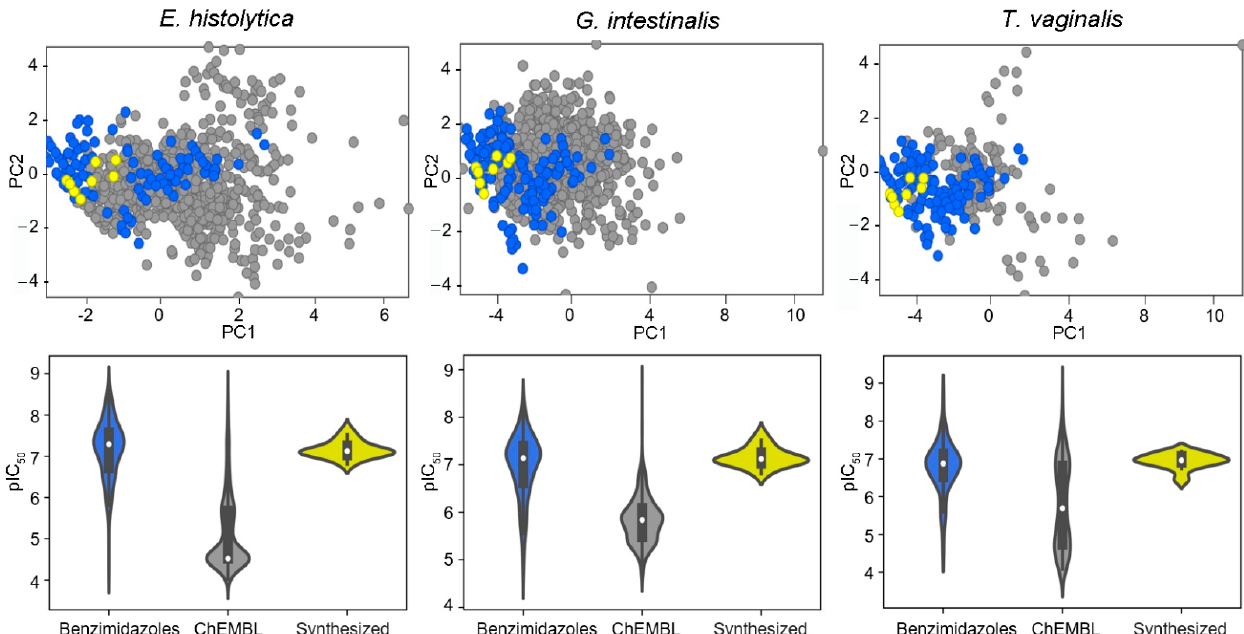
Figure 2. Property space and activity range for 2-phenyl-2 H -indazole derivatives ( 1 – 22 ) synthesized in this work (yellow), a collection of antiprotozoal 1 H -benzimidazole derivatives (blue) and ChEMBL collection of antiprotozoals (gray). The two principal components taken together account for 75.34, 72.44 and 75.71% of the variance for E. histolytica , G. intestinalis , and T. vaginalis , respectively.